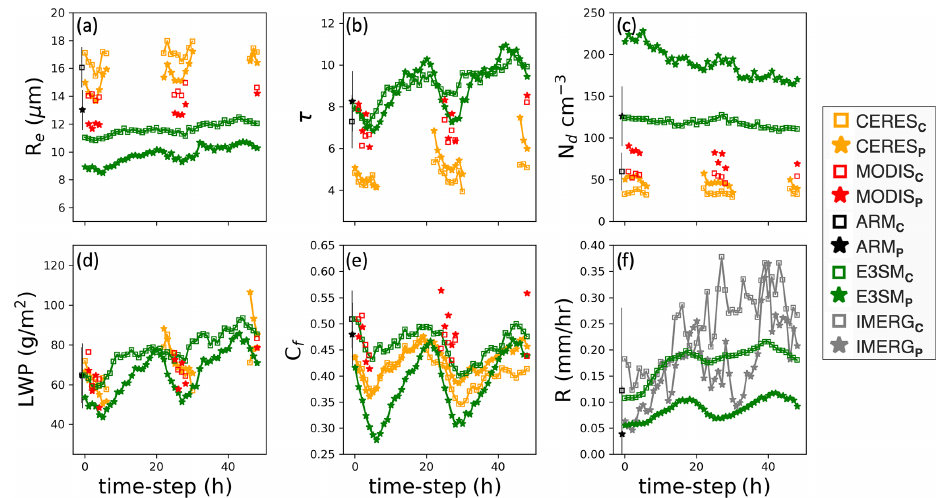
Figure 8. Droplet effective radius (a) , cloud optical thickness (b) , droplet number concentration (c) , liquid water path (d) , liquid cloud fraction (e) , and precipitation rate (f) averaged along the forward trajectories initialized from the ENA site where the air mass is considered polluted (star) and clean (square) for CERES (orange), ARM (black), MODIS (red), and E3SM